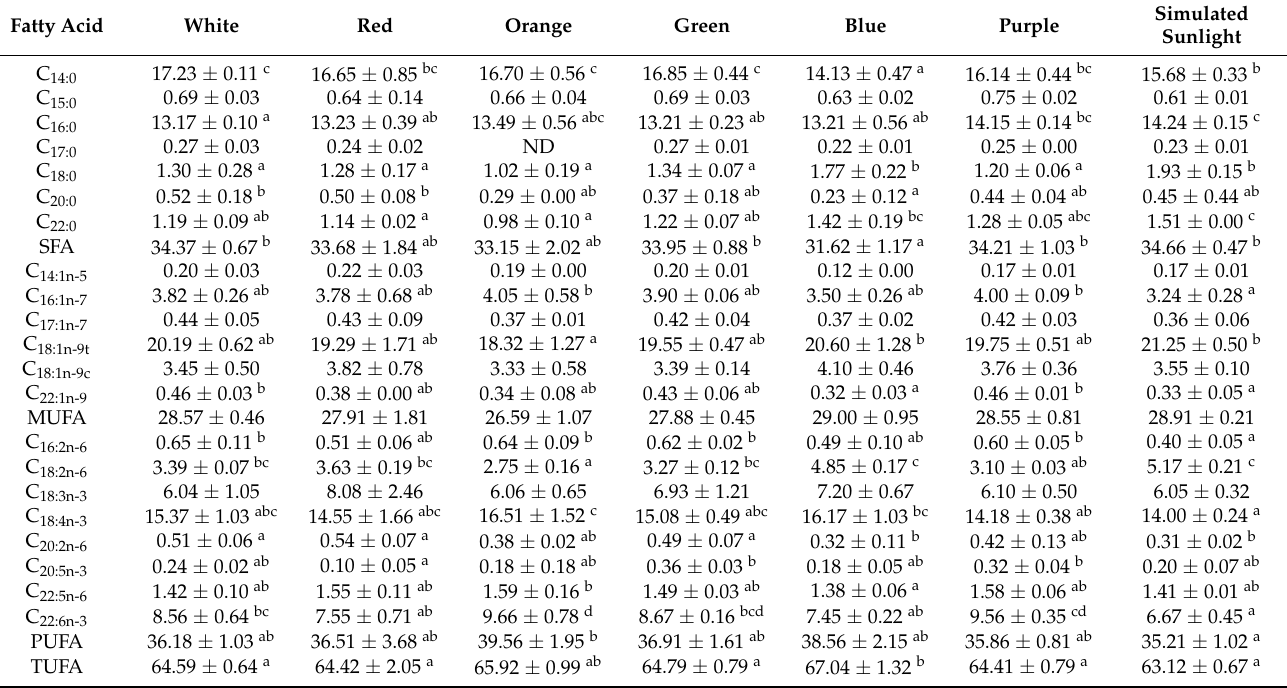
Table 1. Fatty acid composition (percentage of total fatty acids) in I. zhanjiangensis under seven LED